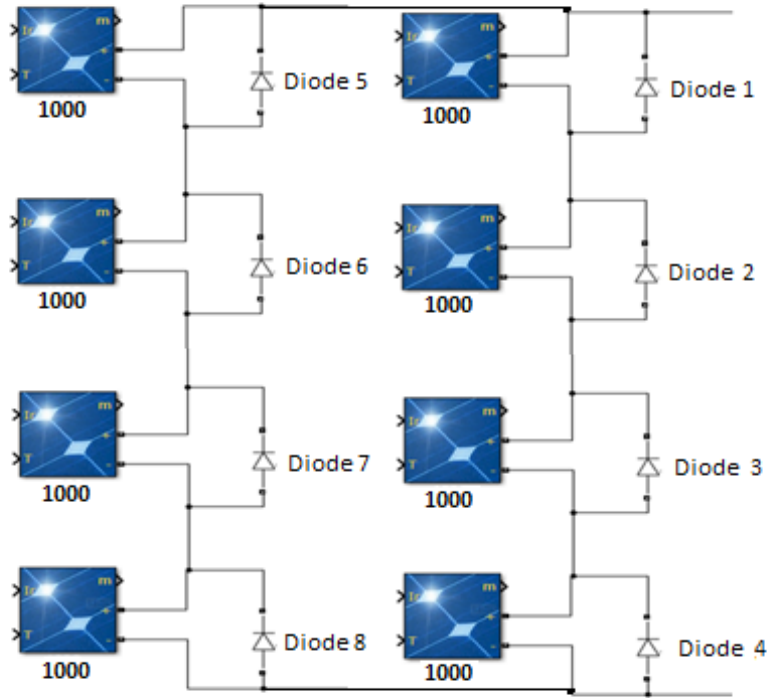
Figure 12. Test cases for 4S2P PV system configuration.